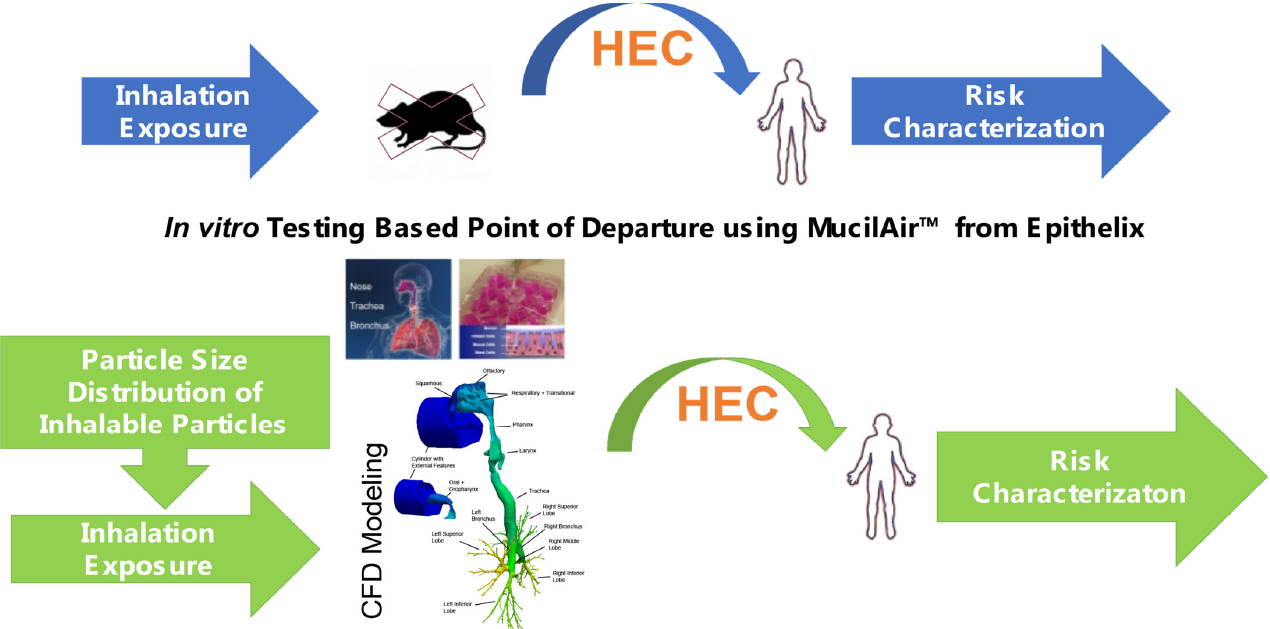
Figure 6. Replacement of default EPA pesticide registration requirement for a 90-day rat inhalation toxicity study for the pesticide chlorothalonil, with an NAM based upon a combination of in vitro toxicity testing with human respiratory cells grown at air–liquid interface (ALI), CFPD modeling for determining human equivalent exposure concentrations (HECs), and characterization of aerosol sizes and distributions under realistic human occupational exposure conditions (from [5,68]; part of NAM-03 presentation, Supplemental File).